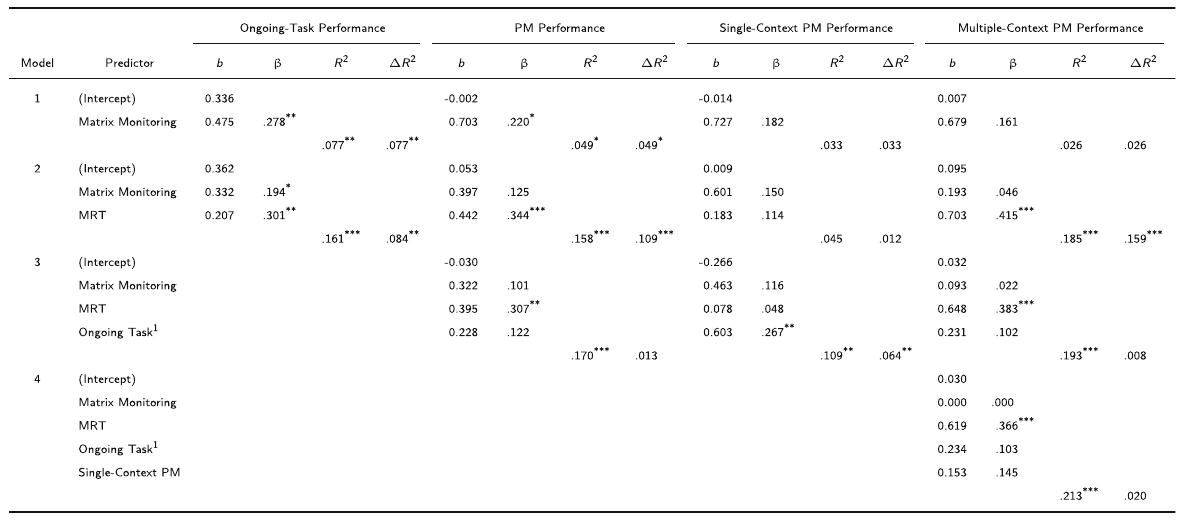
Table 2 Hierarchical regression of the main measures on both PM Performance and Ongoing-Task